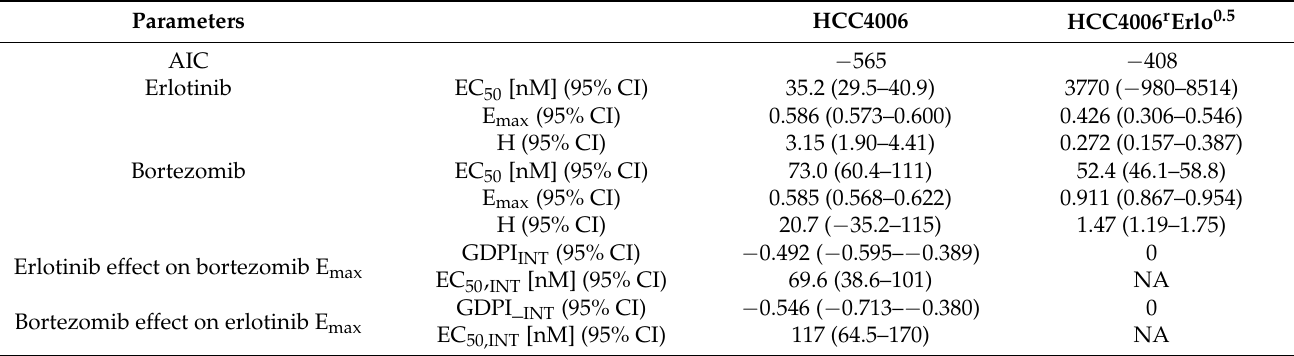
Figure 4. Combination effects of erlotinib and bortezomib in HCC4006rErlo0.5 cells do not deviate from additivity. ( A ) Viability of HCC4006 cells was assessed for combinations of equimolar concentrations of erlotinib (E) and bortezomib (B) and combination index was calculated as explained in the methods section; values represent mean ± SD, n = 3. ( B ) Viability of HCC4006 and HCC4006 r Erlo 0.5 cells was assessed in a checkerboard format. Values represent means of three independent experiments. Simulation was conducted as described in the methods section, * p < 0.05. Table 1. Final General PharmacoDynamic Interaction (GPDI) model parameter estimates and their 95% confidence intervals (CI) for the interaction between erlotinib and bortezomib in the non-small cell lung cancer cell line HCC4006 and HCC4006 r Erlo 0.5 which has been adapted to the epidermal growth factor receptor (EGFR) tyrosine kinase inhibitor erlotinib. AIC: Akaike Information Criterion, EC 50 : Drug potency, the concentration at which half of the maximum effect is reached, E max : Maximum effect, H: Hill coefficient, sigmoidity of the concentration–effect relationship, GPDI INT : GPDI interaction parameter, maximal effect of perpetrator on victim, EC 50,INT : Potency of the interaction, concentration of the perpetrator at which half of the maximum effect on the victim is reached, NA: not